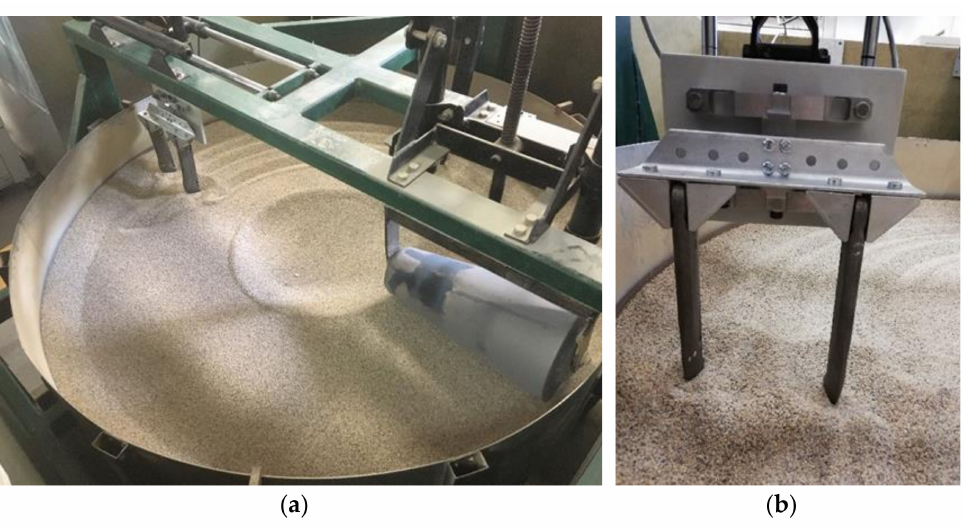
Figure 2. Test stand: ( a ) view of transducer attachment to the tool holder, ( b ) view of symmetrical coulters